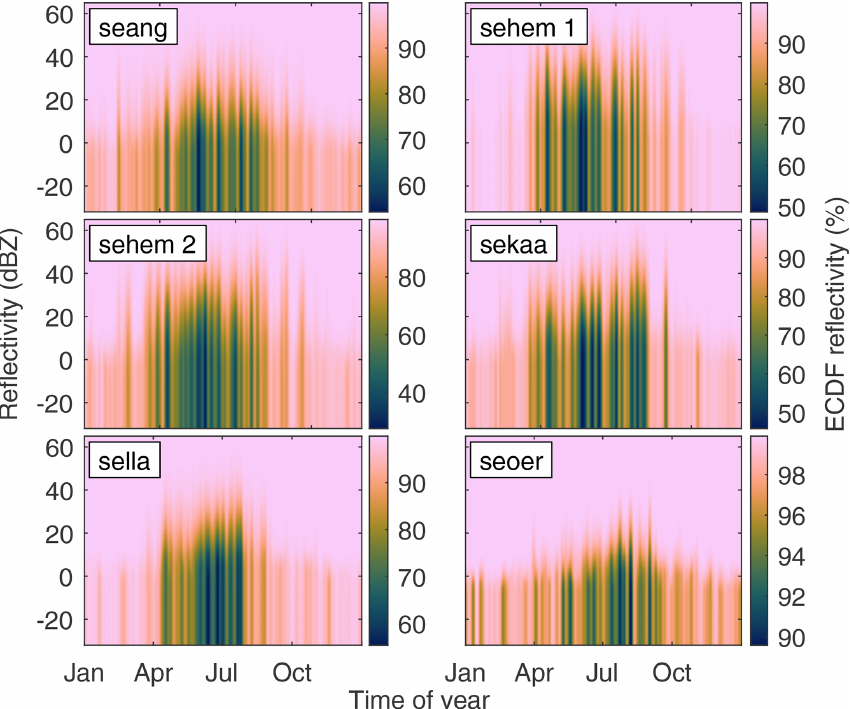
Figure 5. Empirical cumulative distribution function of reflectivity values from all selected groups of radar cells as a function of the time of year.